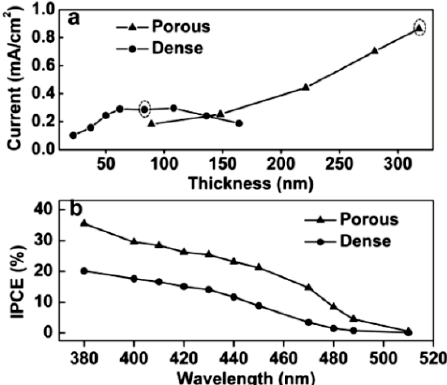
Figure 13. ( a ) The photocurrent at 1.23 V RHE of the porous and the dense Mo doped BiVO 4 films with different thickness in 0.5 M Na 2 SO 4 aqueous solution under front (electrolyte-BiVO 4 surface side) illumination with a 500 W Xe lamp equipped with a 420 nm cut-off filter at a scan rate of 30 mV·s − 1 ; ( b ) IPCE at 1.23 V RHE of the porous and the dense BiVO 4 films in 0.5 M Na 2 SO 4 aqueous solution under front illumination. Reprinted with permission from [41]. Copyright 2018. Wiley.